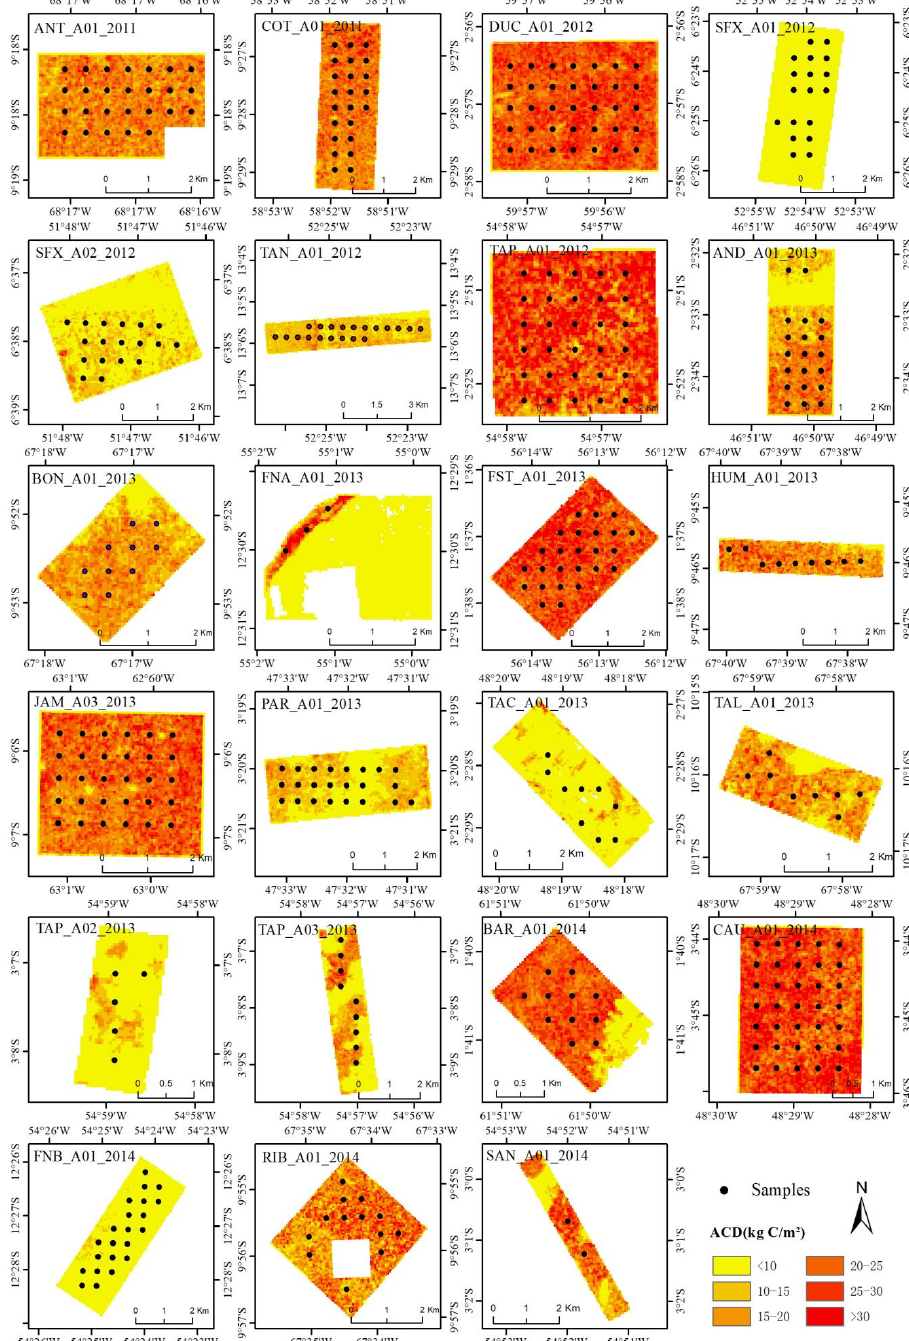
Figure 3. Spatial distribution of predicted aboveground carbon density (ACD) using airborne LiDAR data for 23 study sites in 2011–2014 and the selected samples for modeling and validation. The LiDAR-derived ACD images with a cell size of 50 × 50 m for all sites were aggregated to a cell size of 500 × 500 m using an averaging algorithm to match the MODIS data. The new ACD data were overlaid on the MODIS data for sample plot collection. A systematic sampling approach at one